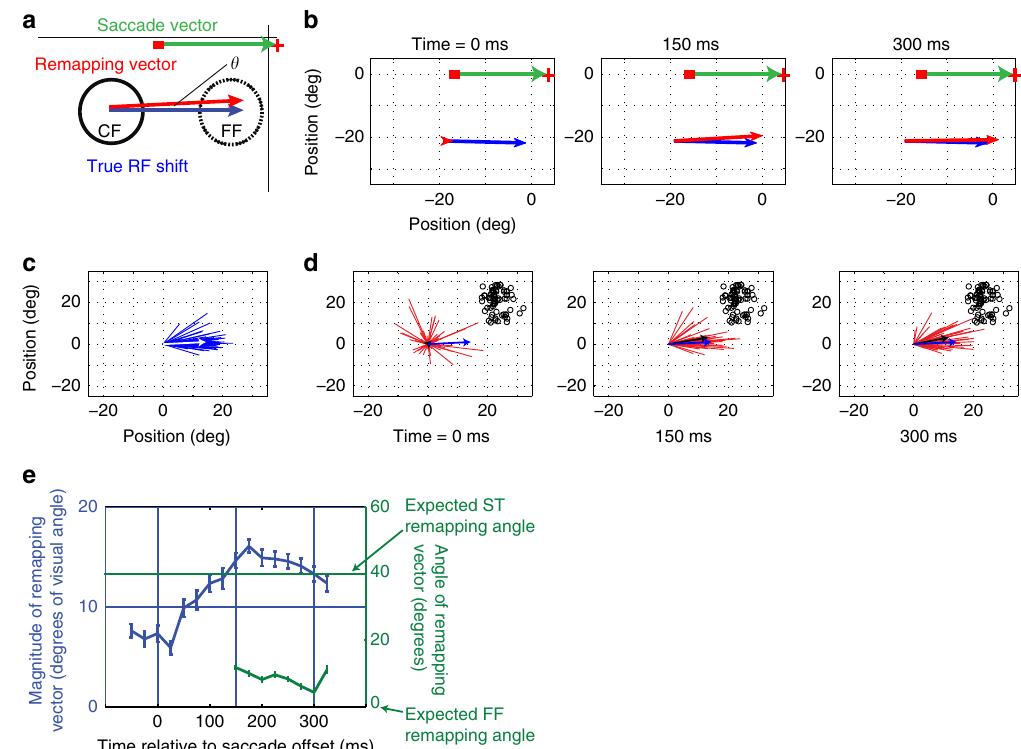
Figure 2 | Quantification of receptive field remapping for away saccades. ( a ) A cartoon of the CF (solid black) and the FF (dotted black) of a hypothetical neuron for an away saccade (green arrow). The true receptive field shift is a vector connecting the centres of the CF and FF (blue arrow). Similarly, the actual remapping vector connects the centre of the CF and the centre of the perisaccadic receptive field (red arrow). The magnitude of this vector and its angle of rotation (indicated by y ) relative to the true receptive field shift vector (blue arrow) are used to quantify receptive field remapping. ( b ) True RF shift vector (obtained by joining RF centres 75ms after P1 and P3 onset, respectively) and remapping vector of the example neuron from Fig. 1b at different times relative to the saccade offset. ( c ) True RF shift vectors of the population of 86 neurons. The white arrow indicates the average vector. ( d ) Remapping vectors of the population of cells at different times relative to saccade offset. The black arrows indicate the average vectors. The blue arrow shows the average true RF shift (same as white arrow in ( c )). Since all the RFs are centred at the origin, the saccade target positions vary (indicated by small black circles). ( e ) Time course of the average magnitude (blue; error bars represent s.e.m. across the population of neurons) and mean direction (green; error bars represent circular s.d.) of the remapping vectors relative to the saccade offset. Vertical lines indicate analysis time points at 150 and 300ms post saccade, as well as saccade offset at 0ms. CF, current field; FF, future field. Figure 3c (left panel) shows the distribution of vectors across Table 1 | Proportion of cells showing different types of the V4 population of 54 neurons (5/59 neurons with RF remapping. eccentricity o 10 (cid:2) were discarded) for the true RF shifts for towards saccades. Again there is a clear mode near zero, which Types of remapping/ corresponds to the angle of the towards saccades executed by the saccade direction monkey. As for away saccades, the actual remapping vectors (Fig. 3d, left panel) as a population were initially untuned (Raleigh non-uniformity test, P 4 0.05, n ¼ 47), indicating no consistent direction of remapping. Later in time, the same distribution was sharply tuned (Fig. 3d, centre and right panels; Raleigh non-uniformity test, P oo 0.001, n ¼ 23 and n ¼ 36, respectively). The means of these angular distributions were not significantly different from 0 (cid:2) (one-sample test; H0: mean slope ¼ 0 (cid:2) ; P 4 0.05, n ¼ 23) at 150 ms, but they were significantly different from zero at 300 ms (one-sample test; H0: mean angle ¼ 0 (cid:2) ; P o 0.05; circular mean ¼ 42 (cid:2) , n ¼ 36), suggesting that the perisaccadic RFs first shifted to the FF, after which they shifted towards the ST (black circles in each figure panel). The FF, future field; ST, saccade target. rotation of the mean of the angular distribution at the later time period was significant to a confidence level of 90% (Watson– Williamson two sample test; F 1 , 57 ¼ 2.56, P ¼ 0.122). Moreover, middle and right panels), the responses to the same probes the deviation of the actual remapping vector angle from zero was evolve in time to show a mixture of FF and ST remapping, as significantly greater for towards saccades than for away saccades the RF centre is displaced away from the FF position towards at 300 ms after the saccade (Watson–Williamson two sample test; the ST. NATURE COMMUNICATIONS|7:10402|DOI: